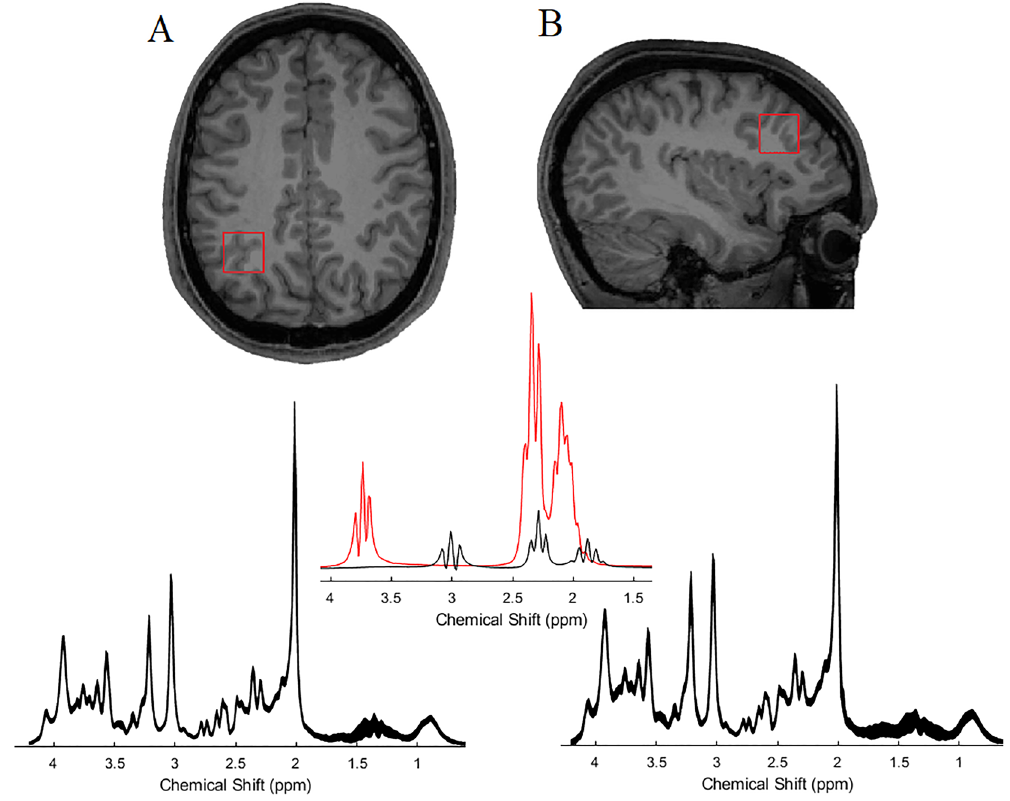
Figure 4. The positions displayed in a T1-weighted image for ( A ) IPS, ( B ) MFG, are shown on axial and sagittal slices, respectively. Below each panel, the mean spectrum from our sample of each region is shown. The line thickness corresponds to ± 1 standard deviation from the mean. The middle panel represents fit spectra for glutamate (red) and GABA (black). (Modified with the permission from 35